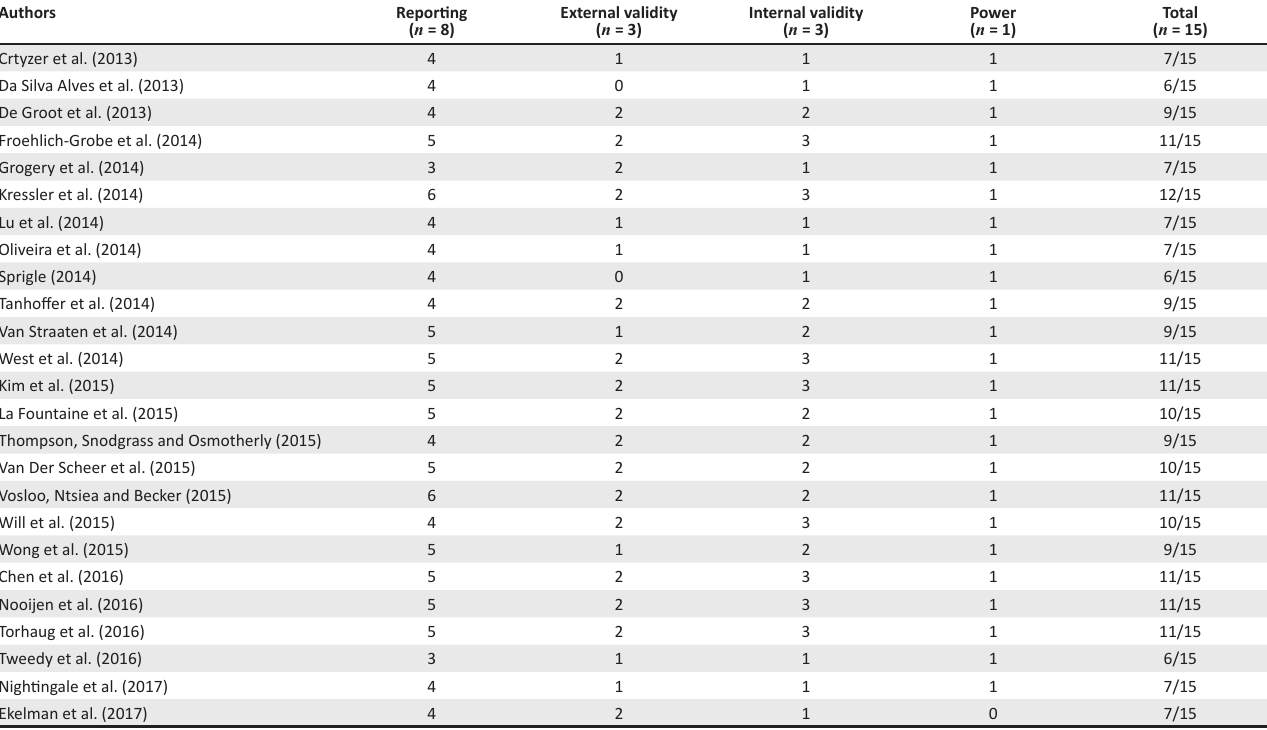
TABLE 2: Appraisal of the papers selected according to Downs and Black Appraisal Scale ( n = 25).